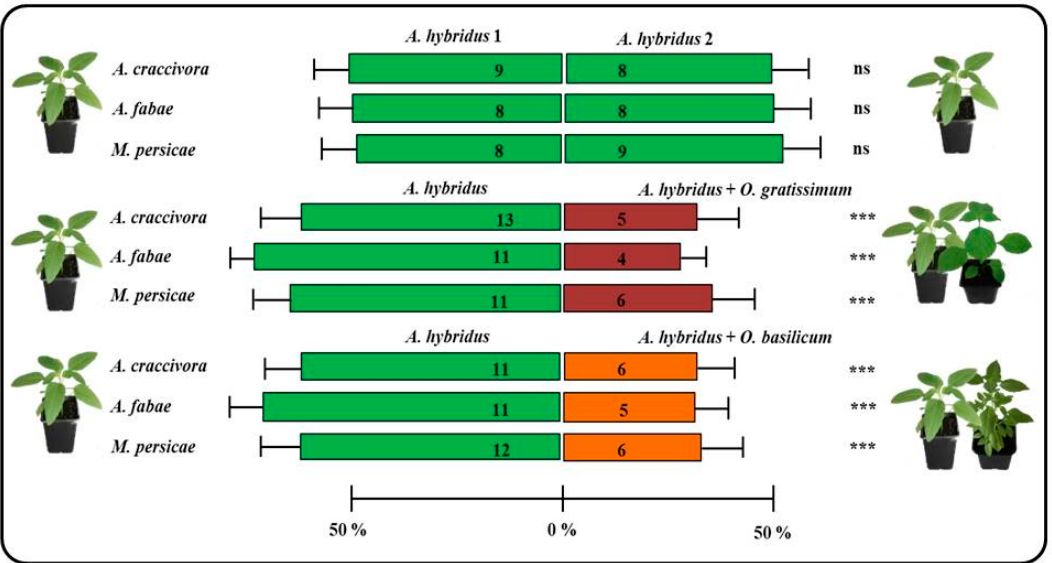
Figure 4. Dual-choice of aphids on an A. hybridus plant associated with O. gratissimum or O. basilicum plants or not 24 h after release in the flight tunnel (mean percentage ± SE, 10 replicates). ns: no significant ( p > 0.05), *** p < 0.001.